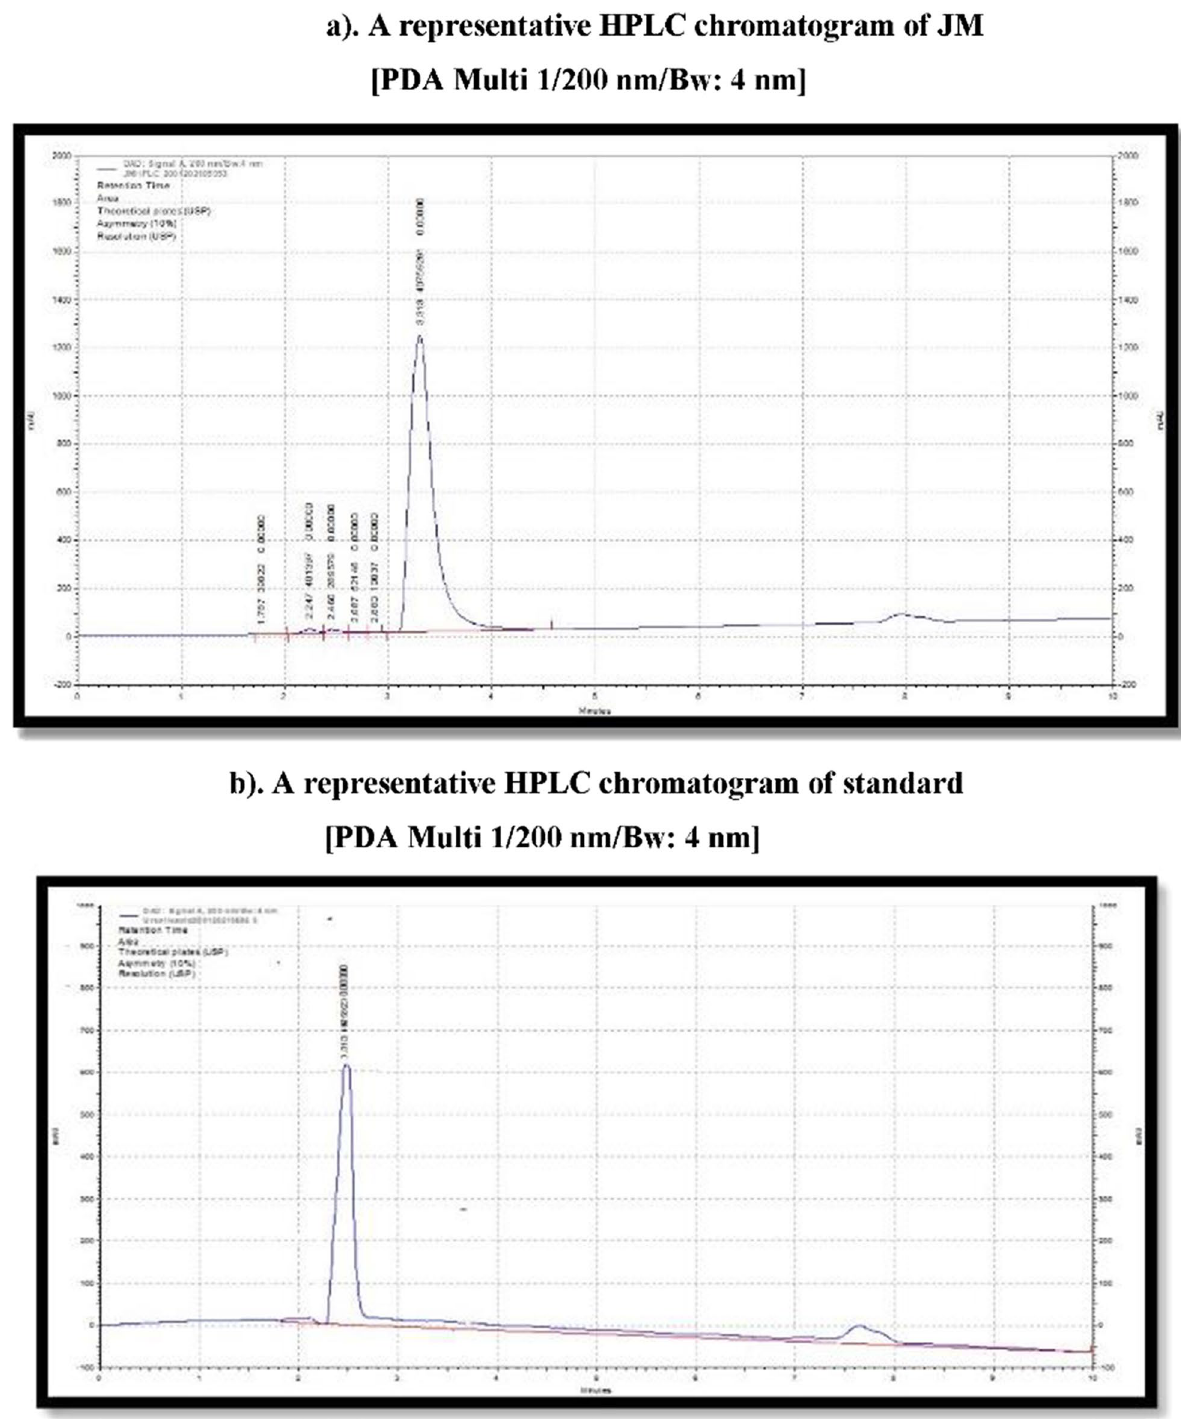
Fig. 1 a A representative HPLC chromatogram of JM [PDA Multi 1/200 nm/Bw: 4 nm]. b A representative HPLC chromatogram of standard [PDA Multi 1/200 nm/Bw: 4